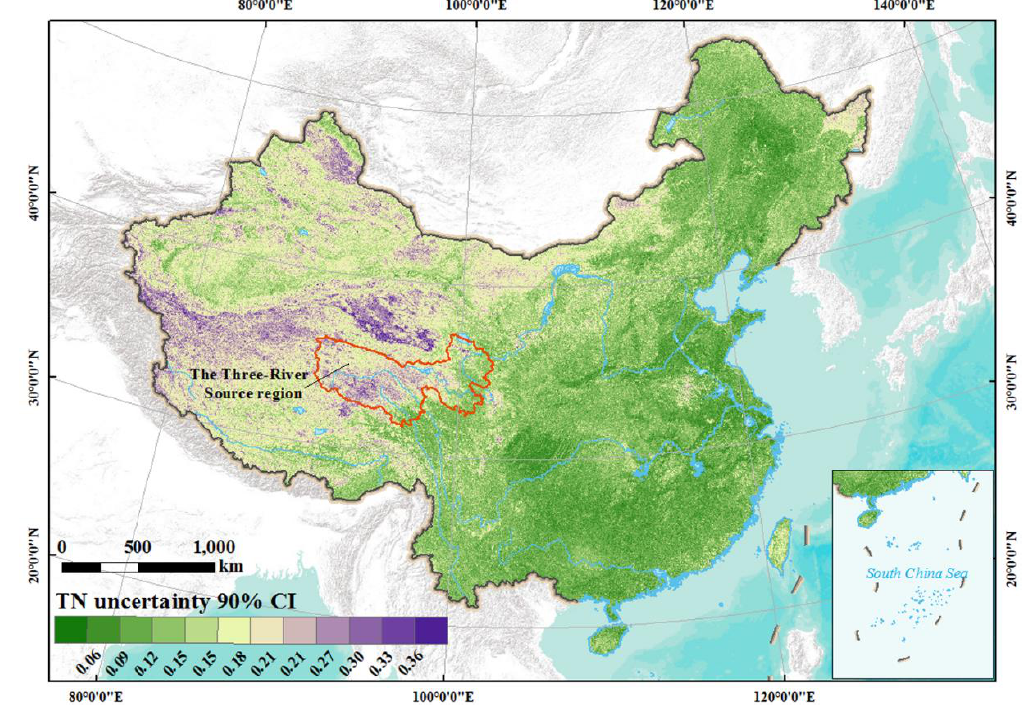
Figure 7. Uncertainty map of soil total nitrogen.